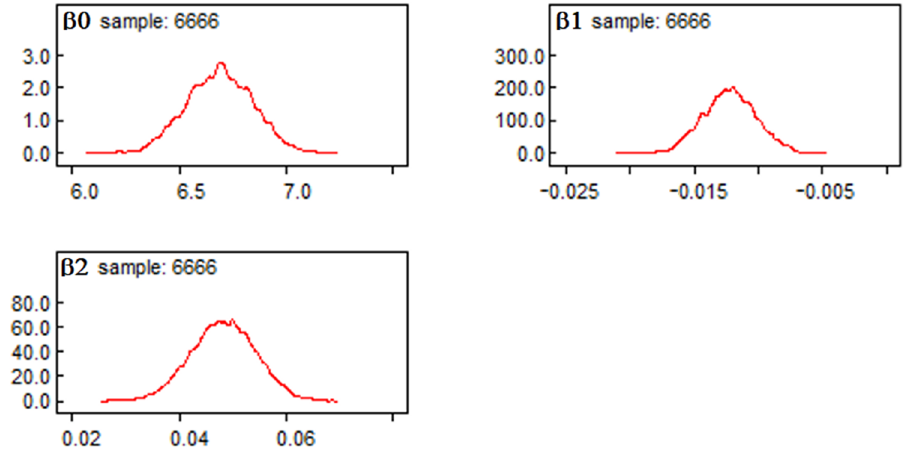
Figure 5. Density plot of MCMC estimation.